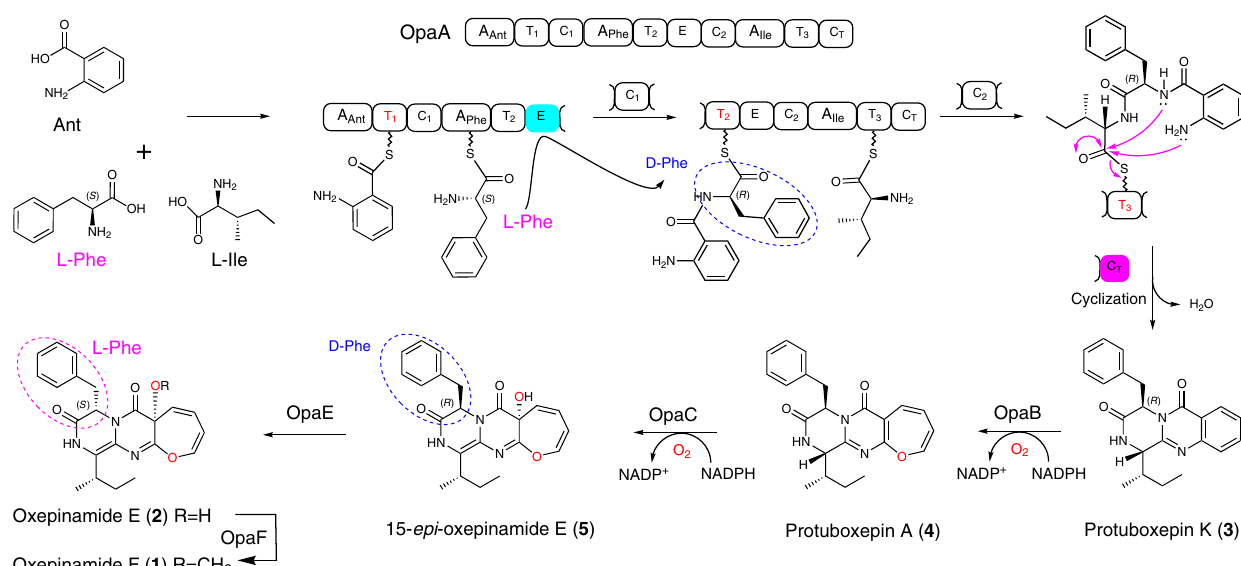
Fig. 6 Proposed biosynthetic pathway for oxpinamide F in Aspergillus ustus . Ant, L -Phe and L -Ile are assembled to protuboxepin K ( 3 ) by the NRPS OpaA with epimerization at the phenylalanyl residue. The oxepinase OpaB catalyzes the oxepin ring formation in protuboxepin A ( 4 ). The regio- and stereospeci fi c hydroxylation of 4 by OpaC is accompanied by a double bond migration, leading to the conversion of a 1 H -oxepin to a 3 H -oxepin system in 5 . The D -Phe con fi guration in 5 is changed to L -Phe in 2 by the single epimerase OpaE. The O -methyltransferase OpaF catalyzes the conversion of 2 to the end product 1 by methylation of the hydroxyl group at